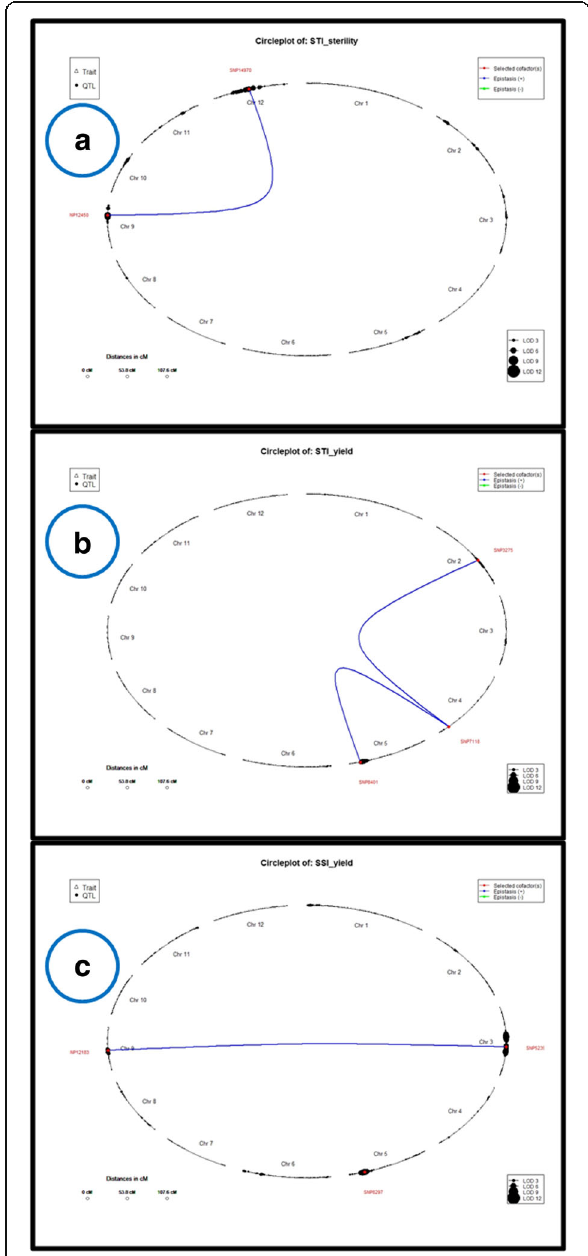
Fig. 5 Epistatic interaction network between SNP marker loci. a STI for sterility ( b ). STI for yield ( c ). SSI for